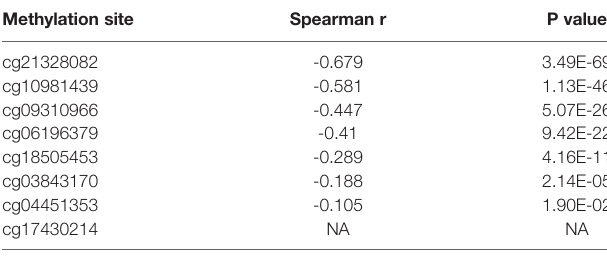
( Table S2 ). The results re fl ect that TREM-1 expression has a stronger correlation with innate immune cells.